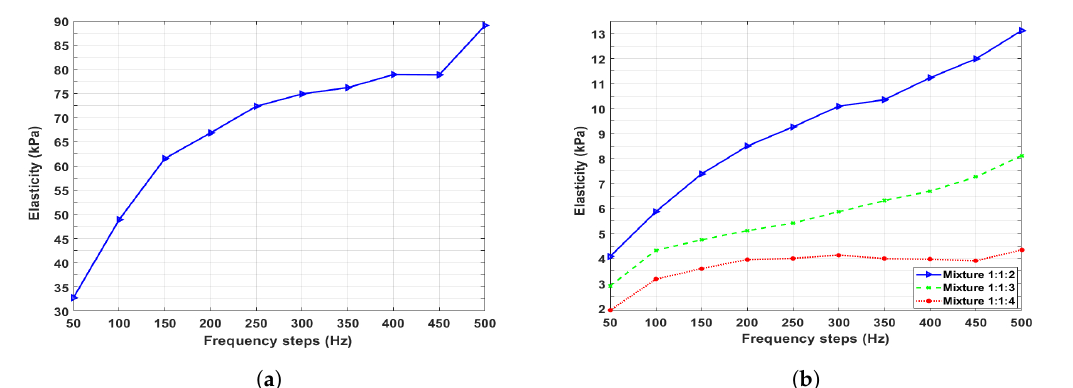
Figure 5. Calculated modulus of elasticity of the four mixtures in pipette with gap boundary condition; ( a ) 1:1:0 mixture; ( b ) 1:1:2 (blue); 1:1:3 (green); 1:1:4 (red)